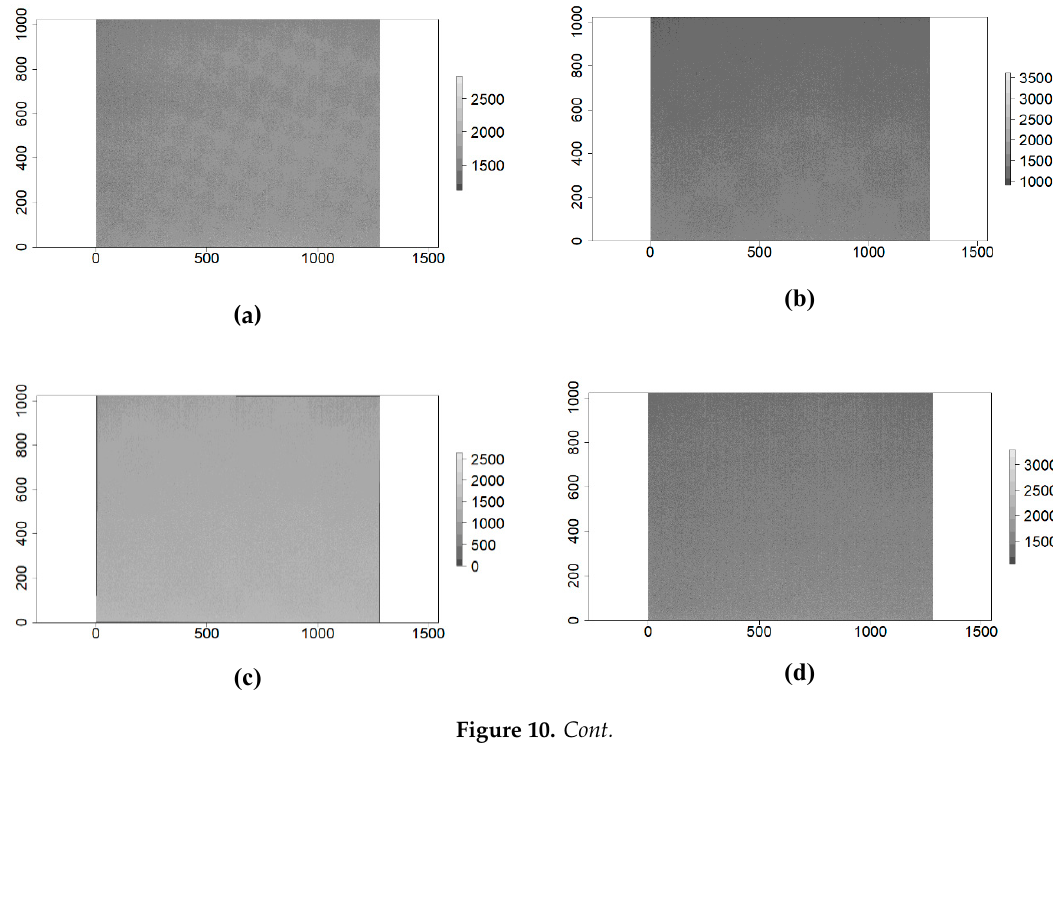
Figure 9. The linear response of the camera at 40% of the integrating sphere source maximum